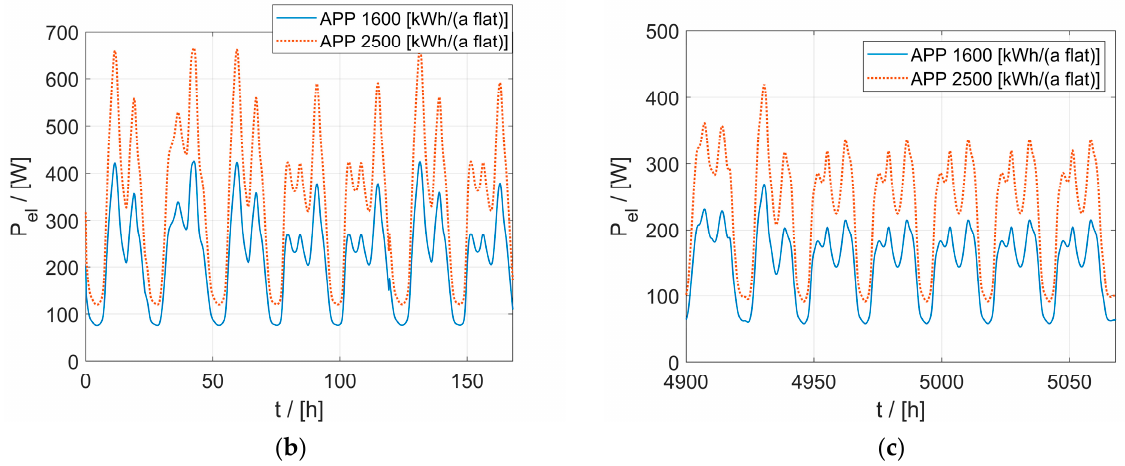
Figure A2. Dynamic appliances profile for one flat used in the simulation of the booster HP ( a ) for the whole year and a zoom of the profile of a winter period ( b ) and of a summer period ( c ).